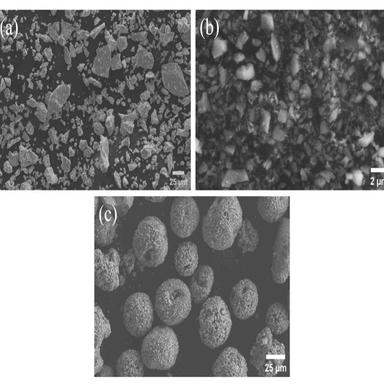
SEM micrographs of the raw powders and composite powder: (a) Nb powder, (b) SiC powder, (c) Nb–SiC composite powder.